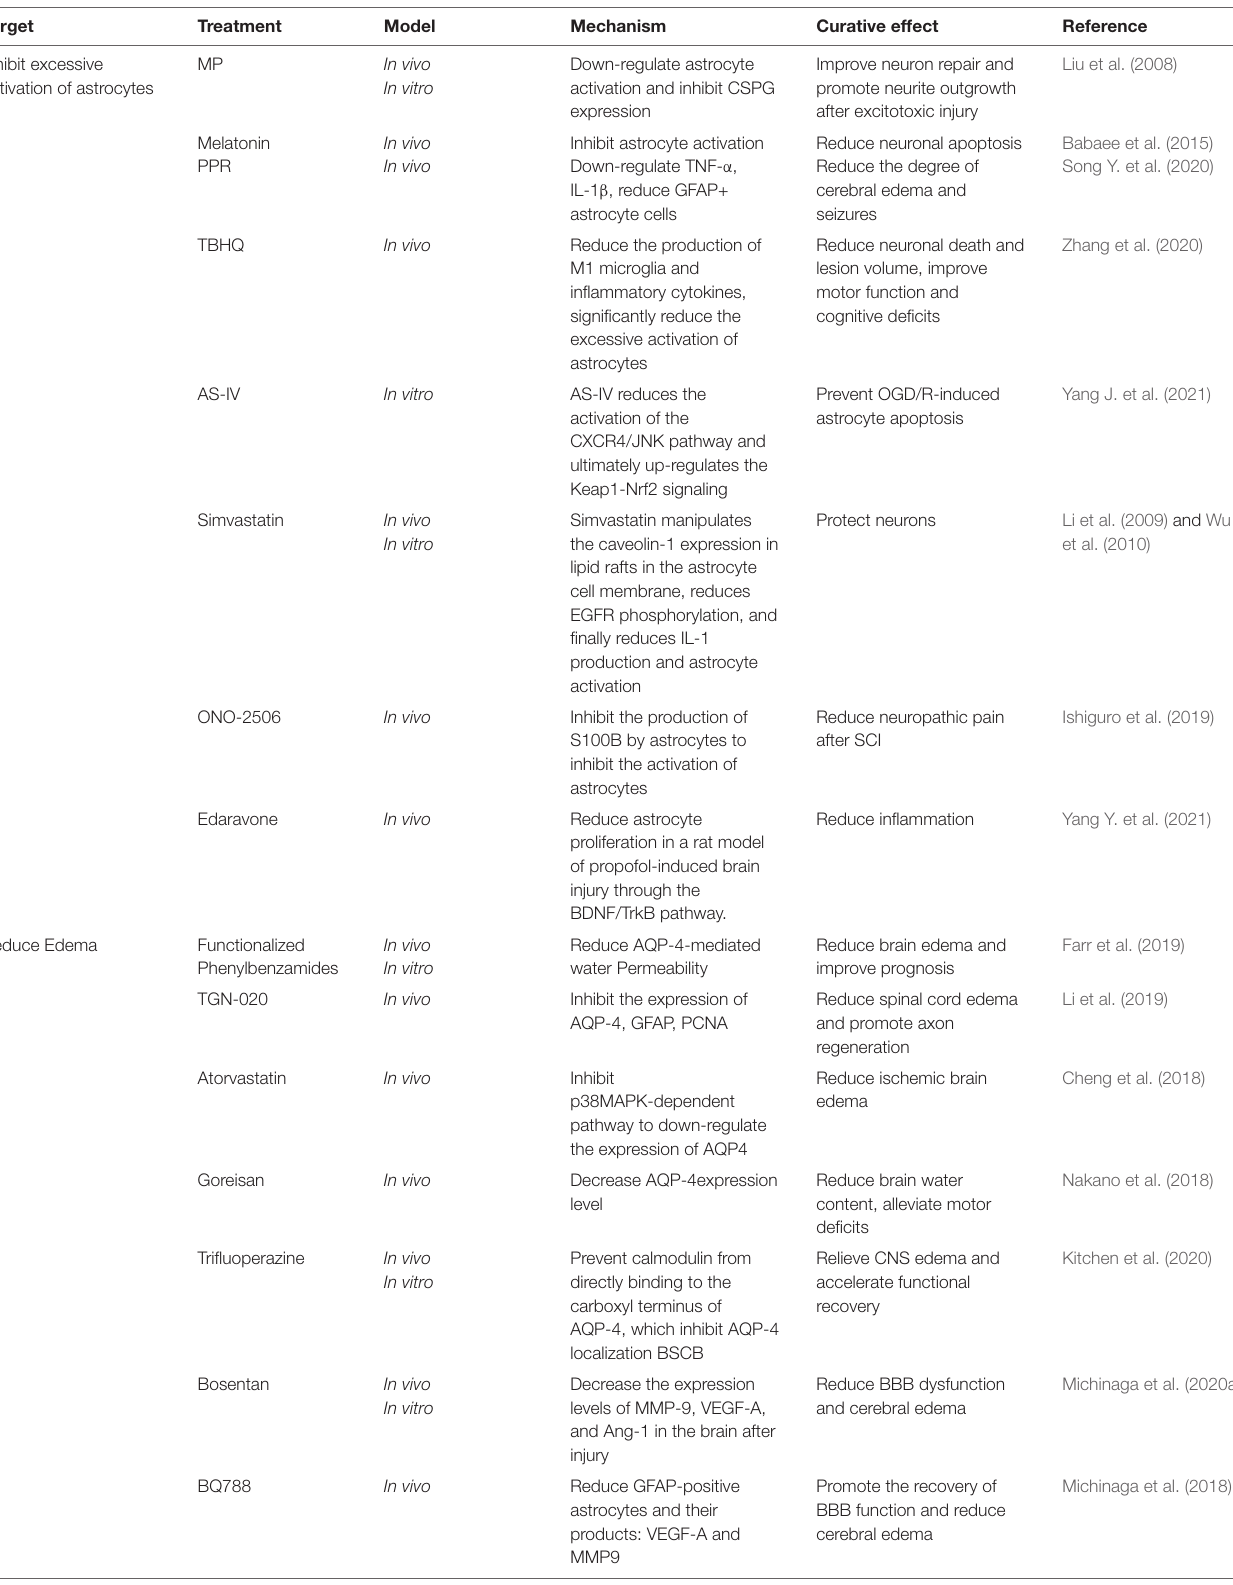
TABLE 4 | Diverse astrocyte targeted therapy